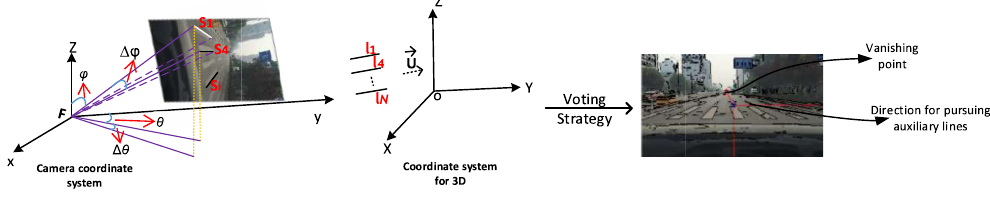
Figure 3. Searching for vanishing points and their directions in a traffic